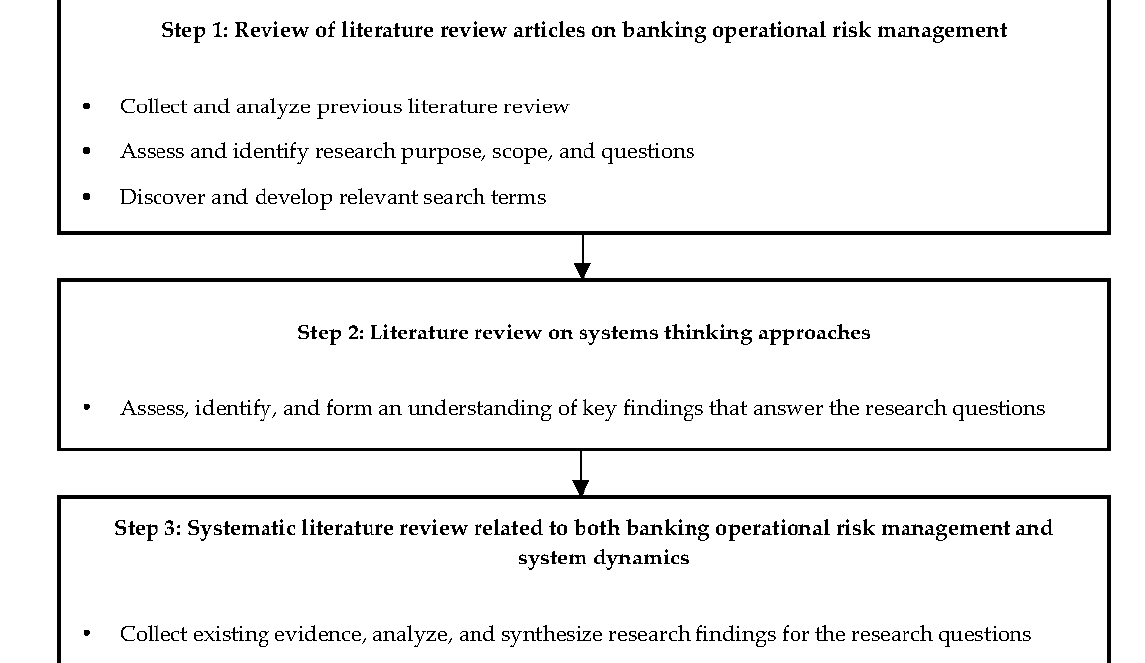
Figure 1. A proposed literature review methodology.